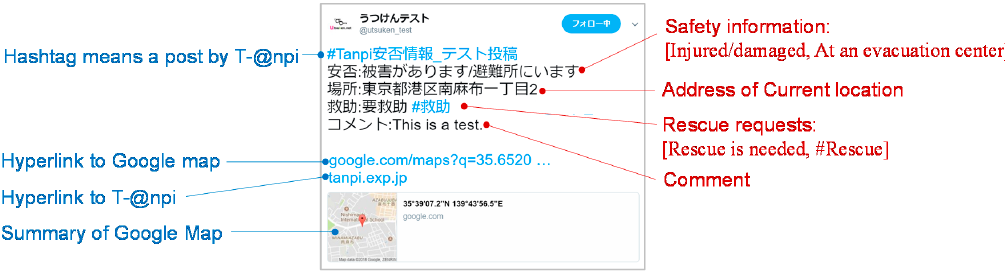
Figure 5. Example tweet of the safety information posted by a user needing rescue from the specified current location.